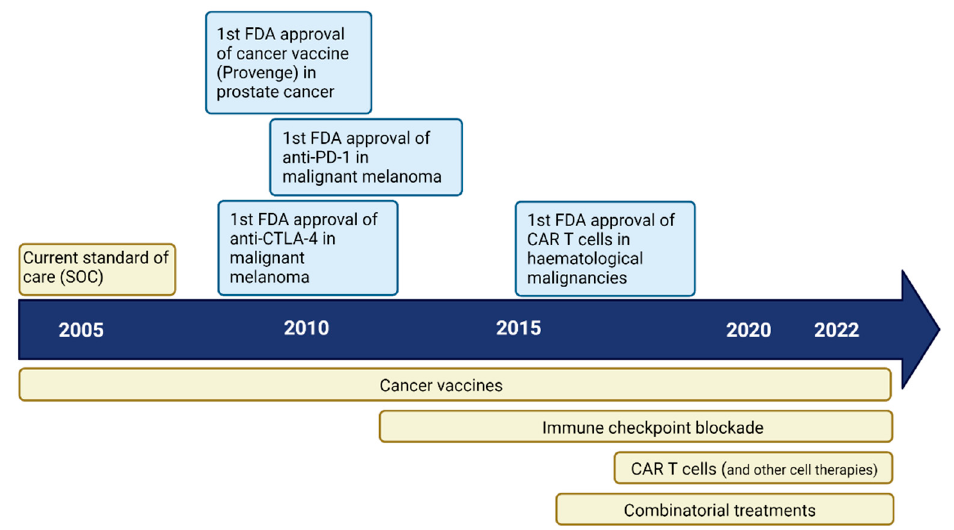
Figure 1. Timeline for immunotherapy development. In blue: immunotherapies approved in other malignancies. In yellow: therapies approved (SOC) or tested in GBM.